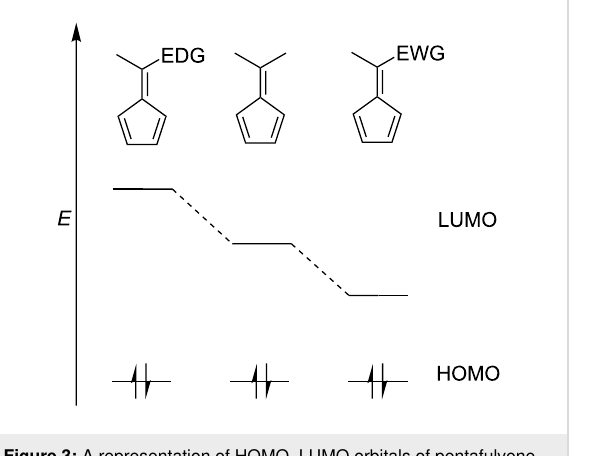
Figure 3: A representation of HOMO–LUMO orbitals of pentafulvene and the influence of EWG and EDG substituents.